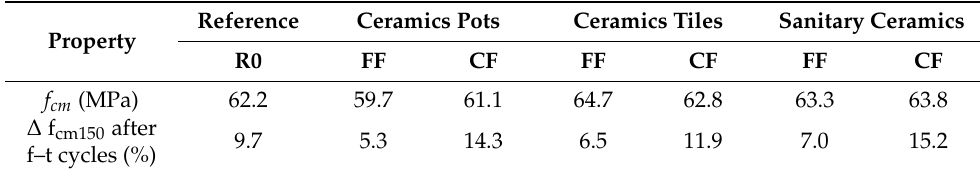
Table 6. The properties of the hardened concretes.